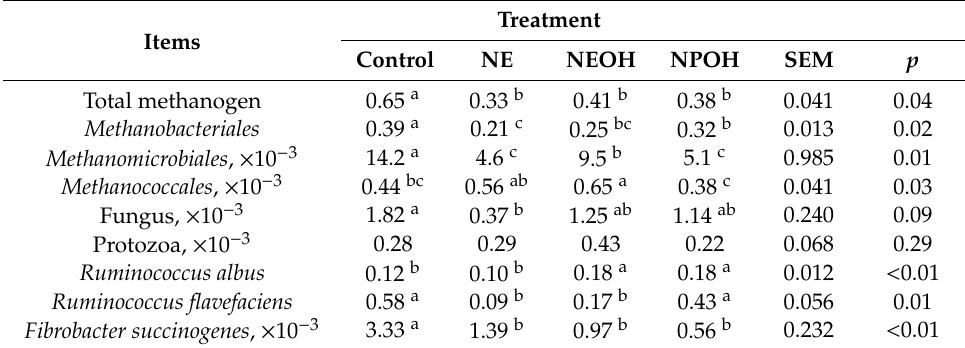
Figure 4. Effect of NE, NEOH, and NPOH addition to culture fluids on acetate ( a ), propionate ( b ), butyrate ( c ), and branched-chain VFA ( d ) of grain-rich feed incubated with rumen fluids obtained from lactating dairy cows. NE: nitroethane; NEOH: 2-nitroalcohol; NPOH: 2-nitro-1-propanol. Statistical analyses showed that the effects of nitrocompounds on acetate and butyrate were significant at p < 0.01, but the effects of nitrocompounds on propionate and branched-chain VFAs were not significant. Table 3. E ff ects of NE, NEOH, and NPOH addition (10 mmol / L) to culture fluids on microorganism relative populations after 72 h